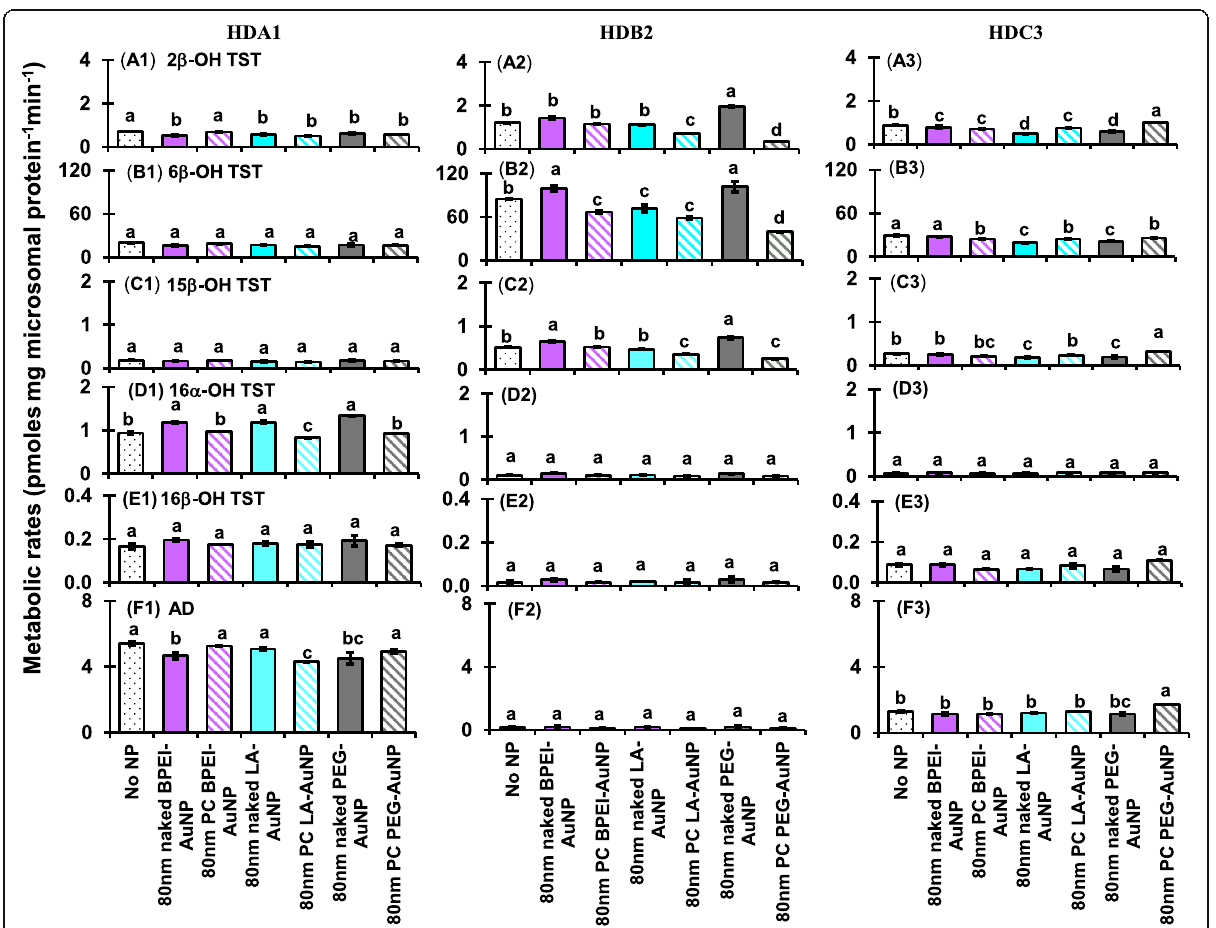
Fig. 9 Effects of 80 nm naked and PC AuNP on the production of 2 β -OH TST (A1 – A3), 6 β -OH TST (B1 – B3), 15 β -OH TST (C1 – C3), 16 α -OH TST (D1 – D3), 16 β -OH TST (E1 – E3), and AD (F1 – F3); in three different single donor HLM (HDA1, HDB2, and HDC3). Means followed by the same letter were not significantly different for each nanoparticle (Tukey ’ s honest significant difference = 5%). Naked no PC, PC human plasma protein corona, HLM human liver microsomes, BPEI branched polyethylenimine, LA lipoic acid, PEG polyethylene glycol, 2 β - OH TST 2 β -hydroxytestosterone, 6 β - OH